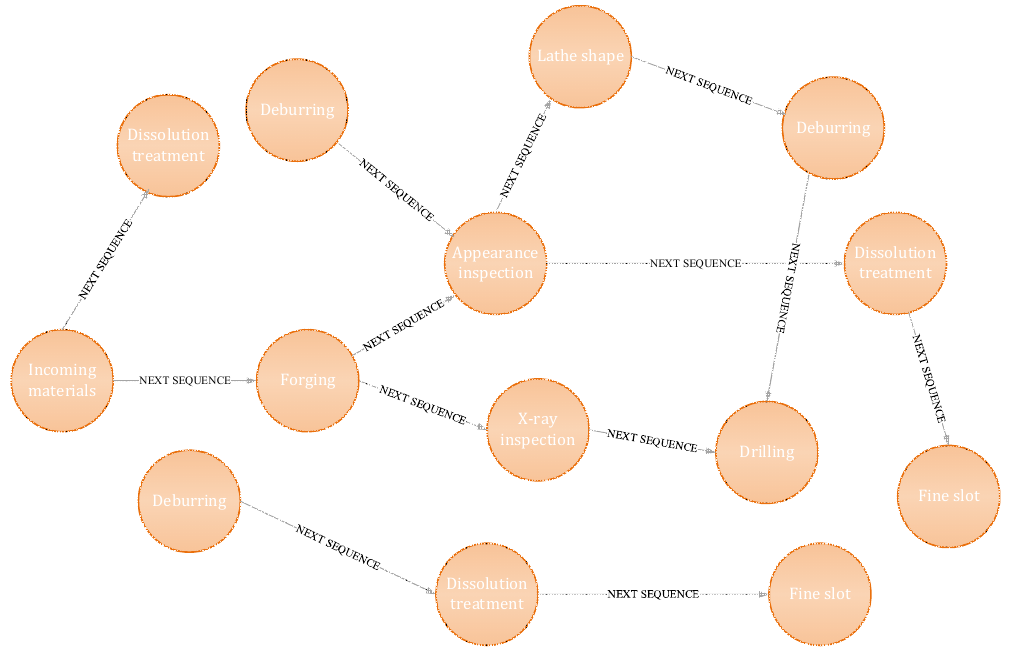
Figure 12. Sample product quality degradation sequence relation visualization based on EABMC.